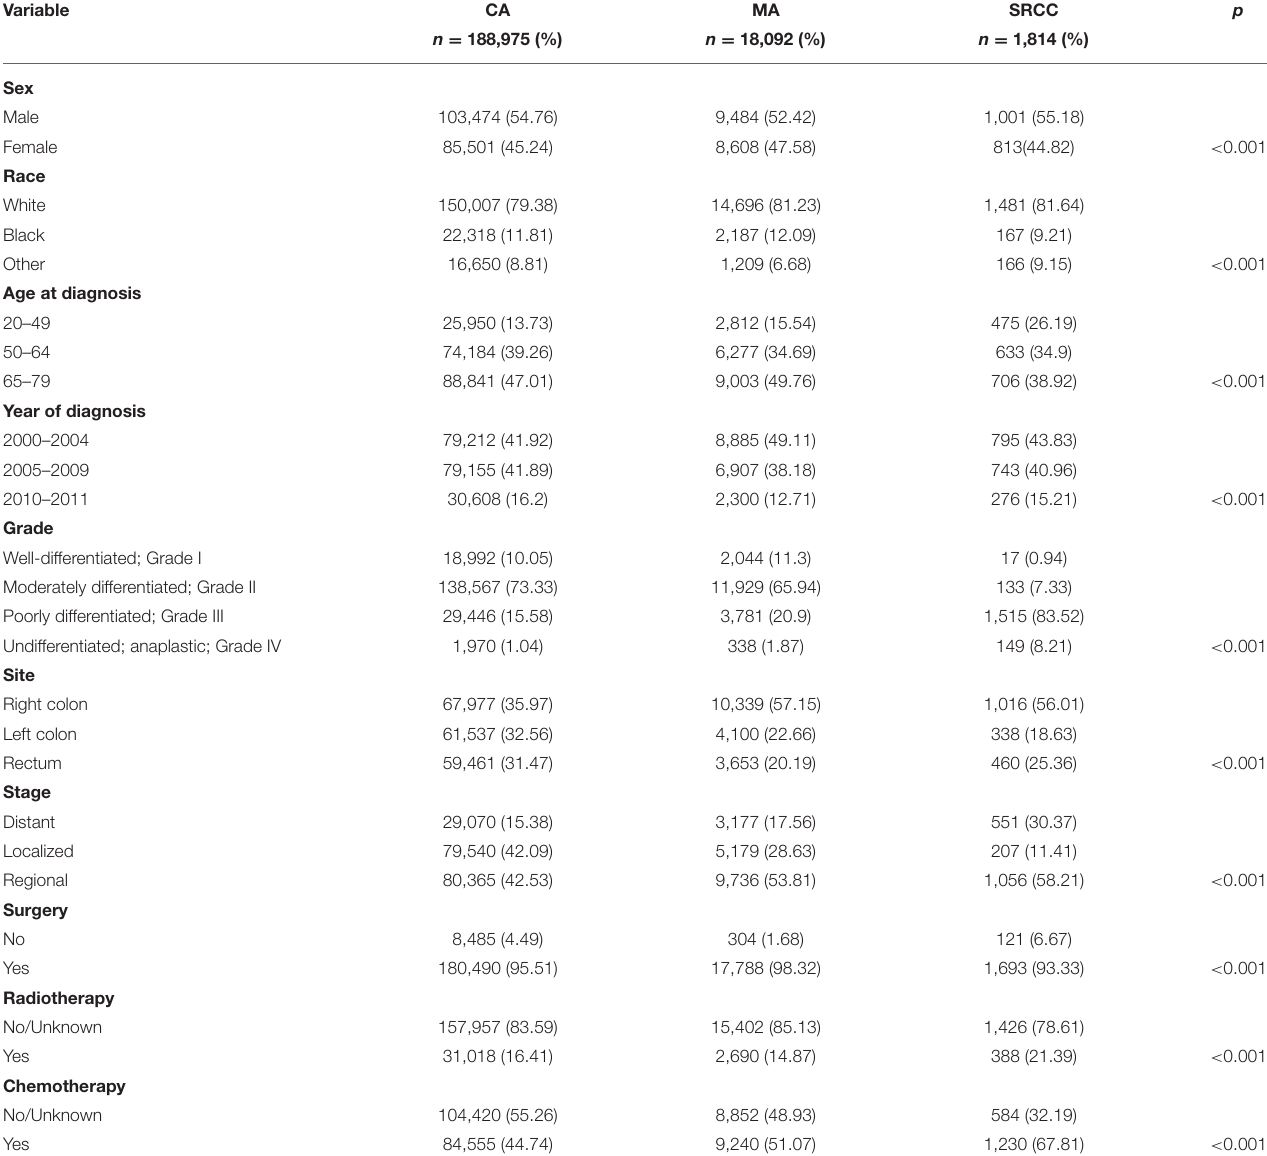
TABLE 1 | Clinicopathological characteristics of patients with colorectal cancer stratified by histological subtypes.